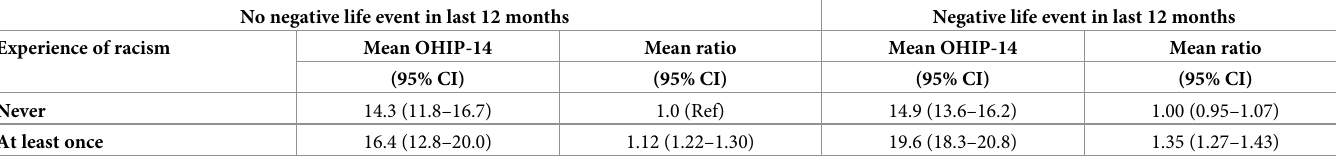
Table 4. Effect measure modification of negative life event on the effect between experience of racism and mean OHIP-14 among Indigenous South Australians. No negative life event in last 12